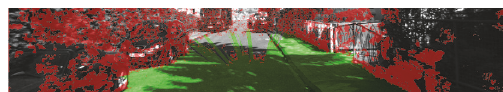
Figure 8: Example of free space detection using a set of rays starting from the bottom center of the image.